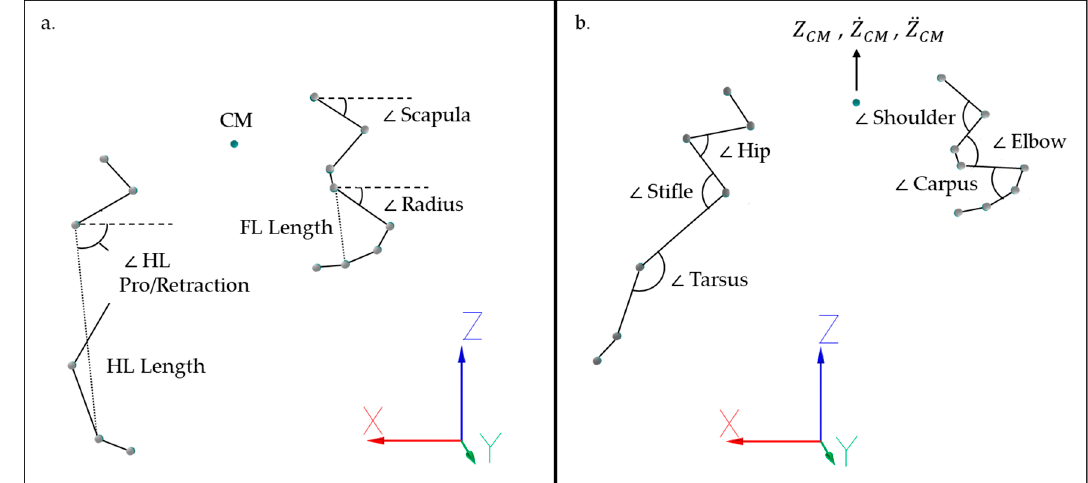
Figure 2. Illustration of joint angles, segment angles, segment lengths and the center of mass (CM) target used to calculate discrete kinematic variables, and the x, y, z axes of the lab coordinate system (LCS). For illustrative purposes, variables are depicted during ( a ) jump take-off and ( b ) jump suspension but were calculated across both A1 and jump strides. ( a ). scapula segment angle, radius segment angle, CM target, forelimb (FL) segment length, hindlimb (HL) segment length, pro/retraction angle of hindlimb (HL) segment ( b ) CM vertical displacement ( 𝑍 (cid:3004)(cid:3014) ), CM vertical velocity ( 𝑍(cid:4662) (cid:3004)(cid:3014) ), CM vertical acceleration ( 𝑍(cid:4663) (cid:3004)(cid:3014) ) and an illustration of the flexor side of shoulder, elbow, carpus, hip, stifle and tarsal angles.